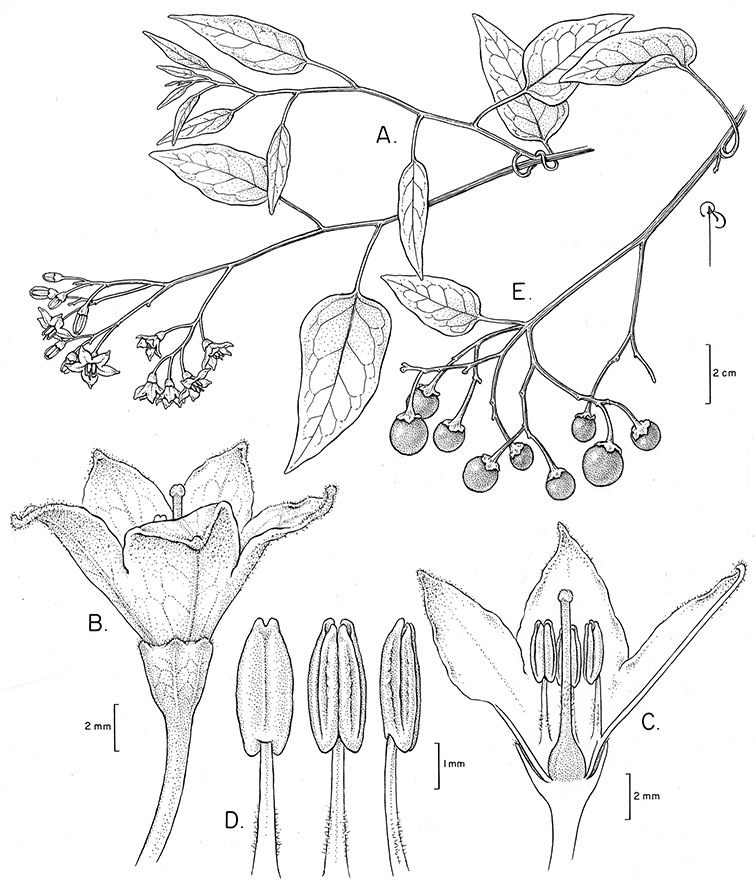
Solanum sousae S. Knapp. (A–D drawn from Ventura 2212, E from Maya J. 3938). Originally published in Knapp (2010). Illustration by Bobbi Angell.